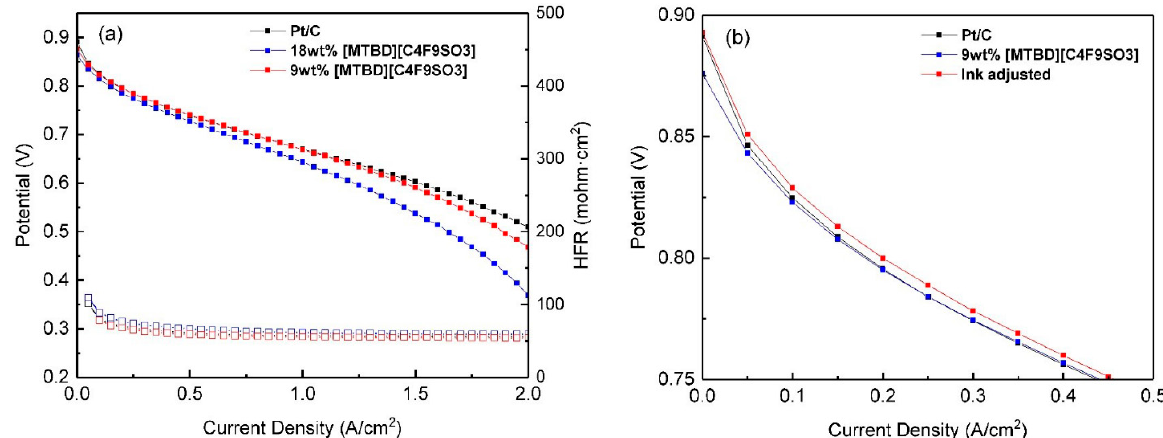
Figure 9. Polarization curves of ( a ) Comparison of Pt/C, Pt/C-[MTBD][C 4 F 9 SO 3 ] (18 wt.% and 9 wt.% IL loading). ( b ) Comparison of Pt/C, Pt/C-[MTBD][C 4 F 9 SO 3 ] (9 wt.%), and Pt/C-[MTBD][C 4 F 9 SO 3 ] (9 wt.%) after adjustment of ink formulation (red curve). All MEA results were obtained at 70 °C and 100 RH under gauge pressure of 150 kPa.